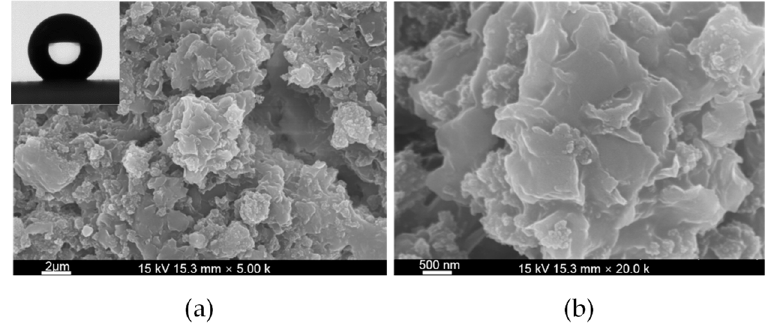
Figure 1. Scanning electron micrograph (SEM) images of the super-hydrophobic methyl silicone resin/SiO 2 composite surface.